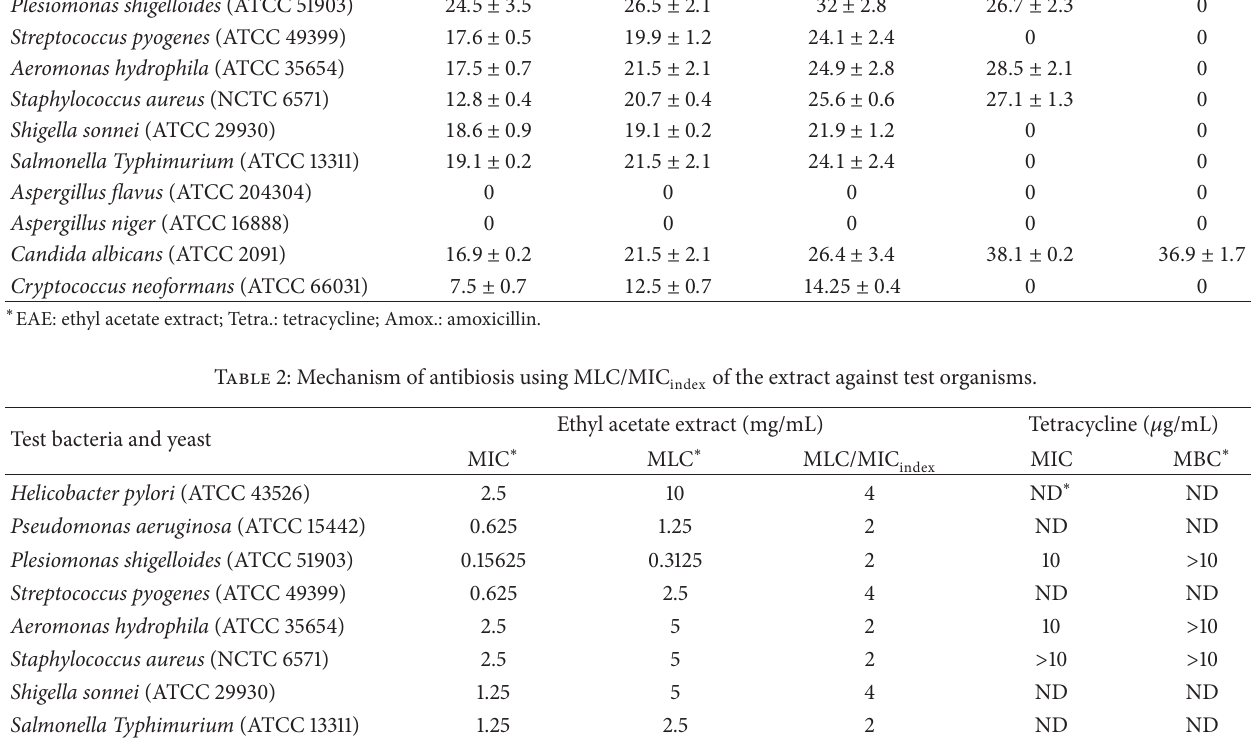
Table 1: Antimicrobial susceptibility test of the ethyl acetate extract compared with standard antibiotics. Test bacteria and fungi